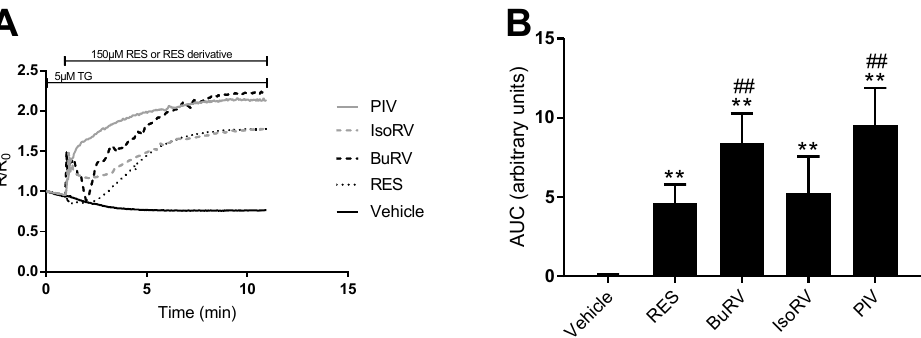
Figure 5. RES and RES derivatives inhibit plasma membrane calcium ATPase (PMCA). MDA-MB-231 cells were loaded with Fura-2, placed in a Ca 2+ -free media, and treated with the SERCA pump inhibitor, thapsigargin (TG), to deplete endoplasmic reticulum (ER) calcium. Placing the cells in Ca 2+ -free media and depleting ER calcium with TG isolates the activity of PMCA; thus, PMCA inhibition will be reflected by an increase in [Ca 2+ ] i . Cells were then treated with 150 μ M RES (dotted, black), PIV (solid, gray), IsoRV (dash, gray), BuRV (dash, black), or a vehicle (solid, black). The increase in [Ca 2+ ] i is shown as a time trace ( A ) and quantified by the area under the curve ( B ). The data are a representation of three biologic replicates. ** indicates p < 0.01 compared to the vehicle control, and ## indicates p < 0.01 compared to RES.